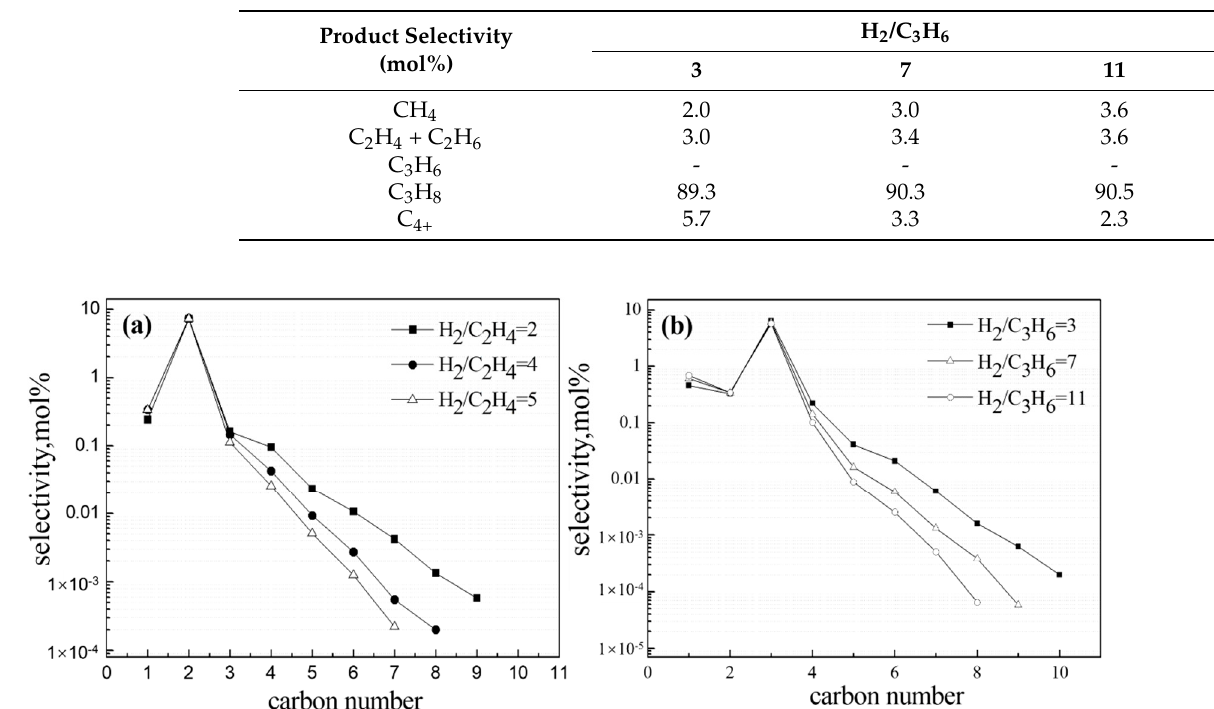
Figure 2. The product distribution of the light alkene reaction (T = 533 K, p = 0.8 MPa). ( a ) C 2 H 4 in H 2 atmosphere. ( b ) C 3 H 6 in H 2 atmosphere.